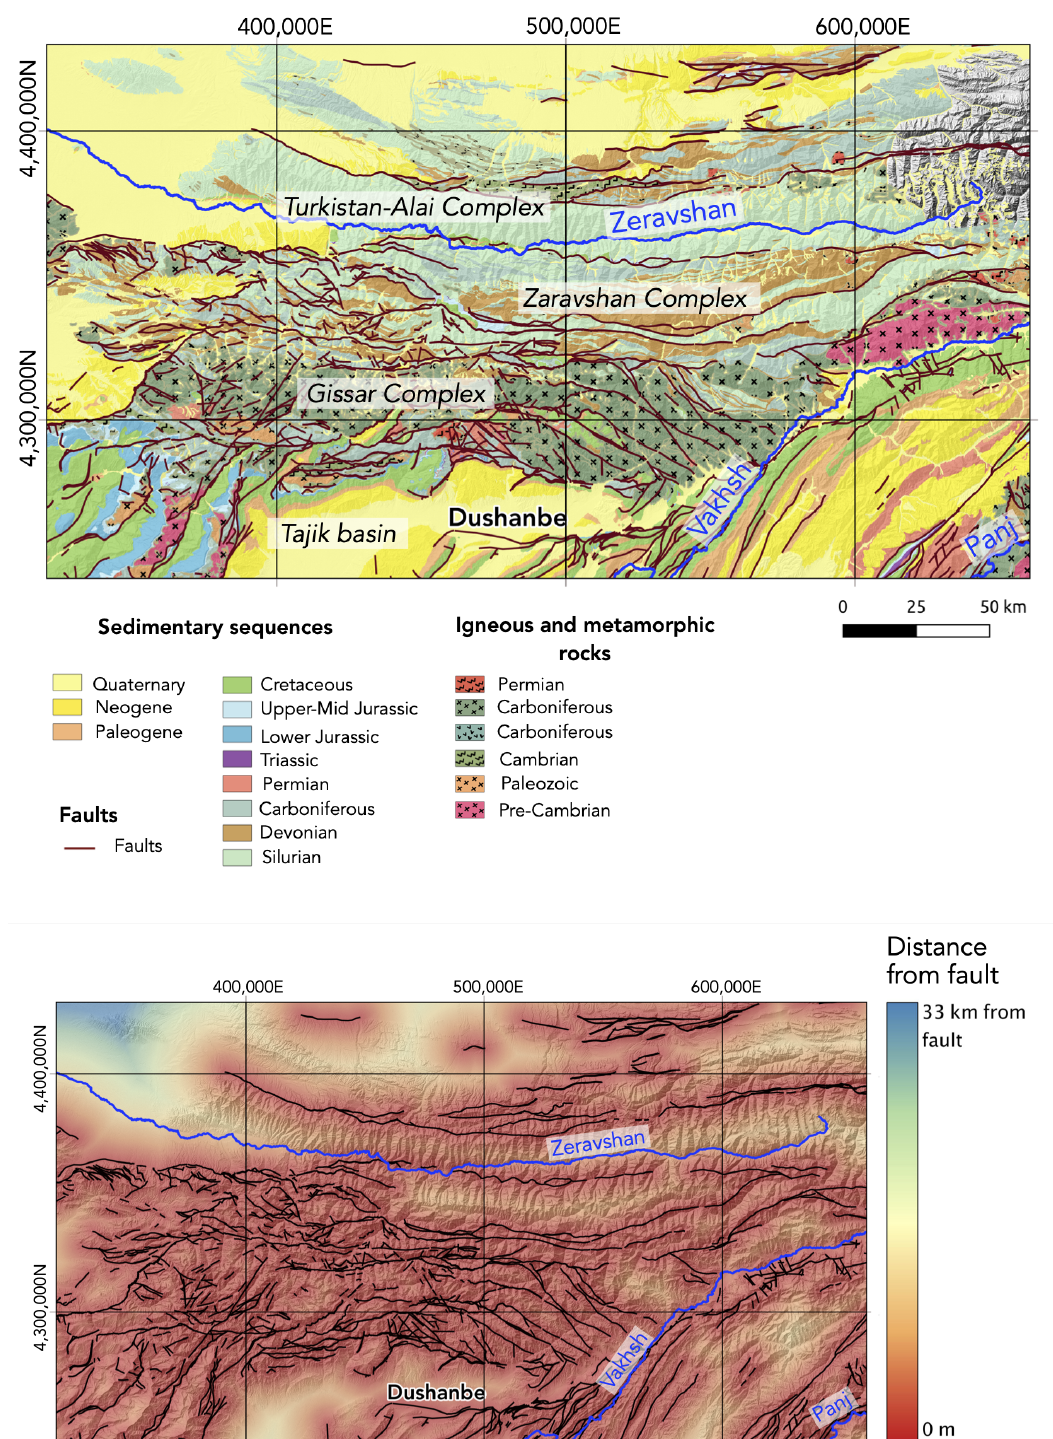
Figure A1. Geology and